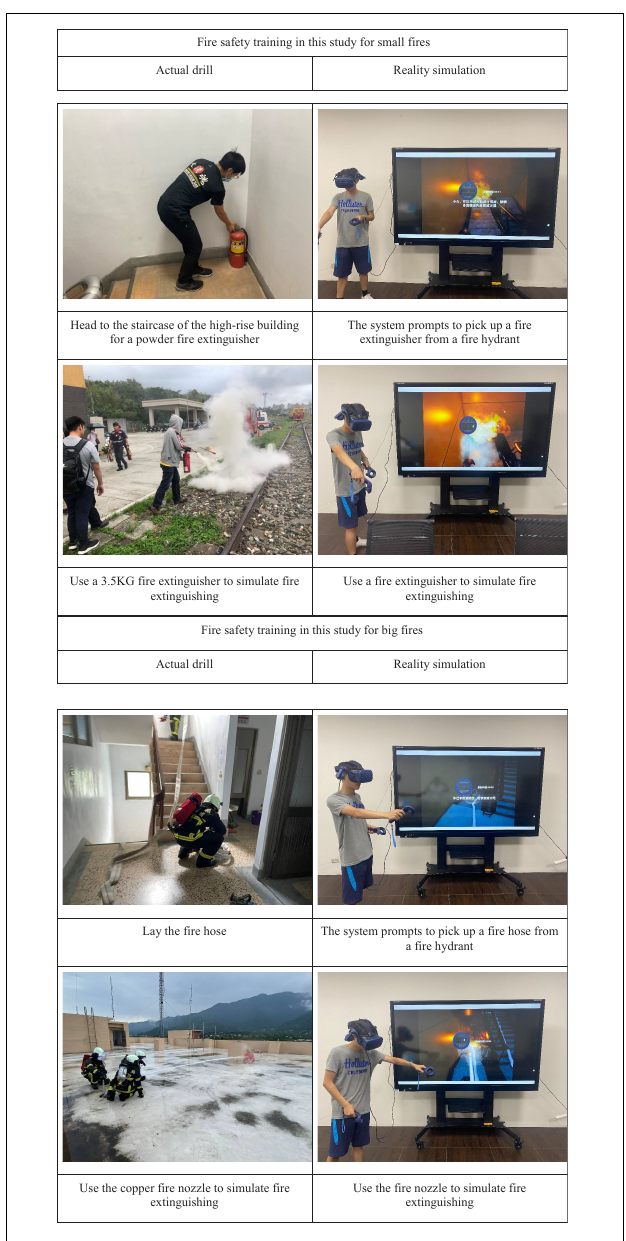
FIGURE 1 | Fire safety training in this study (actual drill and reality simulation).